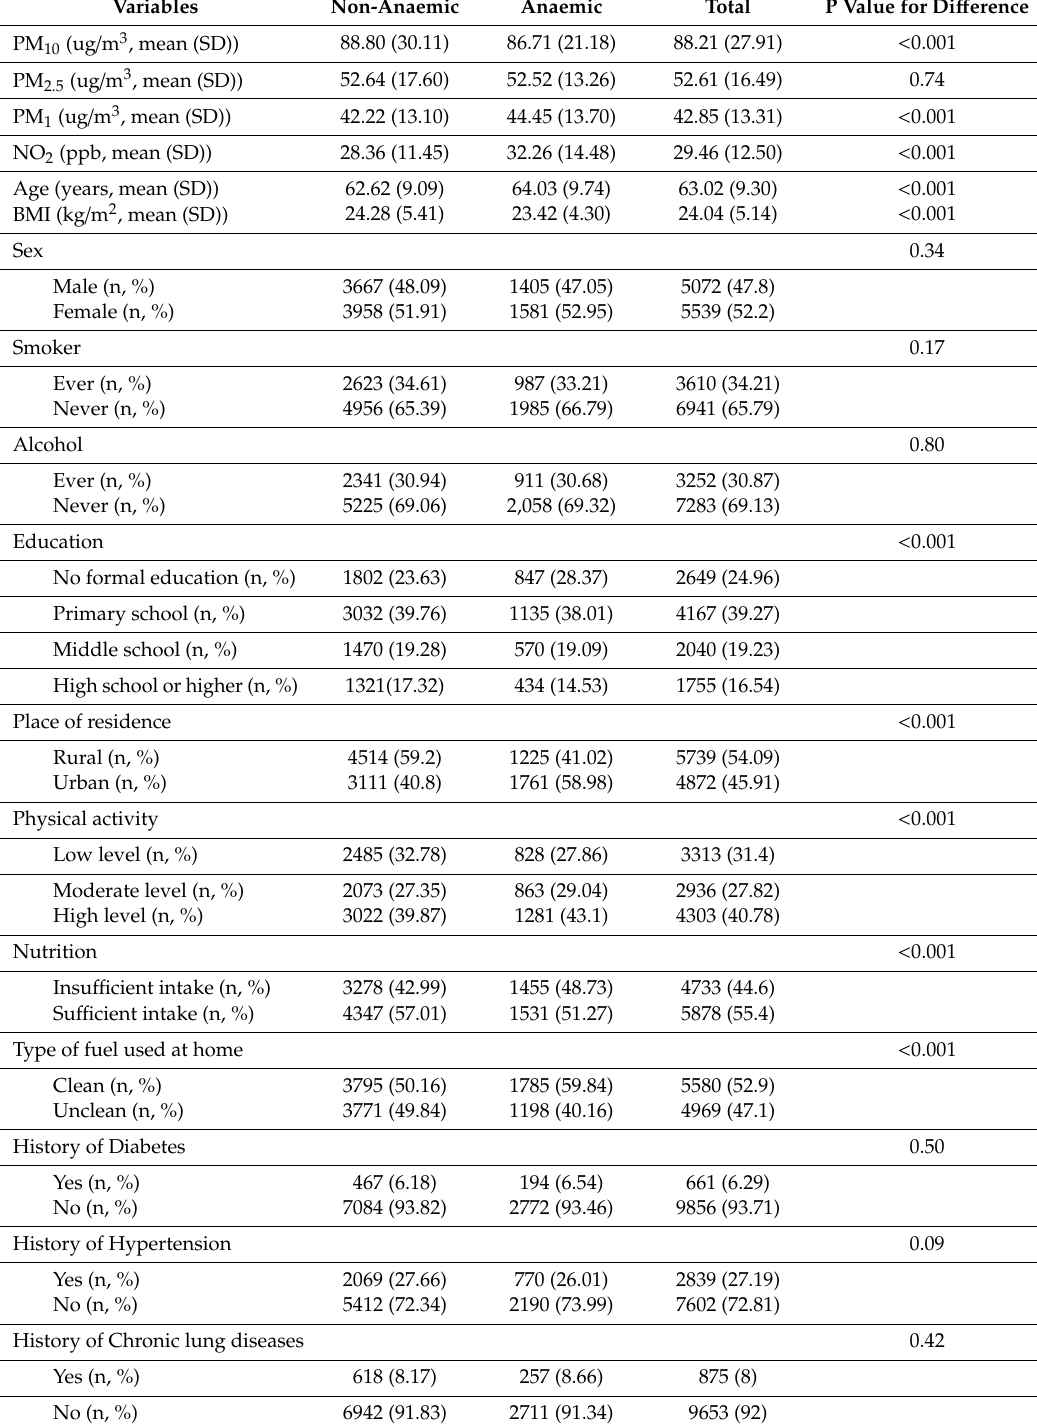
Table 1. Characteristics of the older adults’ study participants in the 64 communities of Study of Global Ageing and Adult Health (SAGE) China Wave